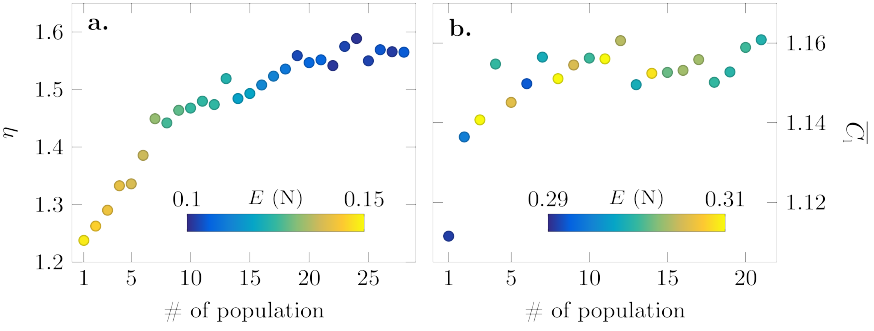
Figure 5. Convergence of the fitness functions for ( a ) the maximum stroke average efficiency objective and ( b ) the maximum stroke average lift objective. The color of the markers indicates the aerodynamic energy associated with the pitching motion solutions.